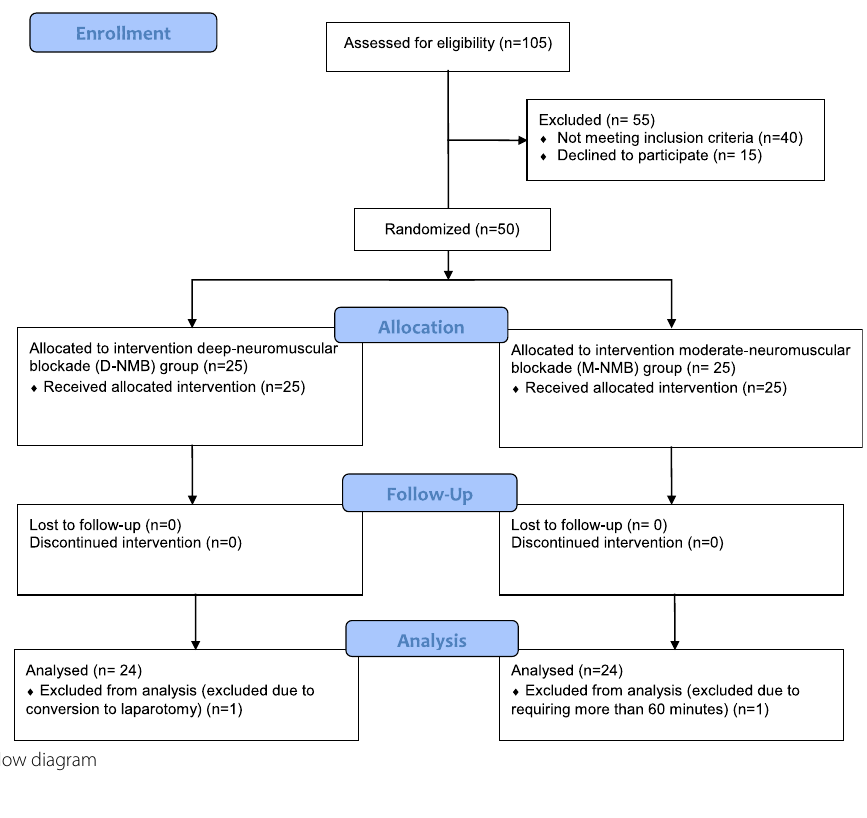
Table 1 Characteristics of patients